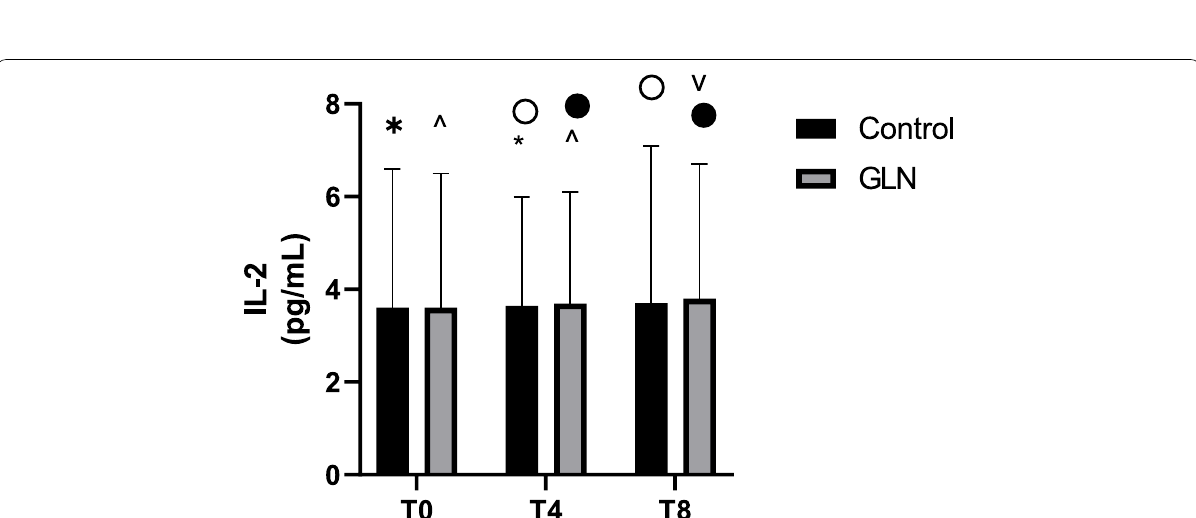
Fig. 5 IL-2 levels in control and glutamine (GLN) groups. Data are presented as mean group ( p < 0.05); * and ° indicate a significant difference in the control group between T0 and T4 ( p